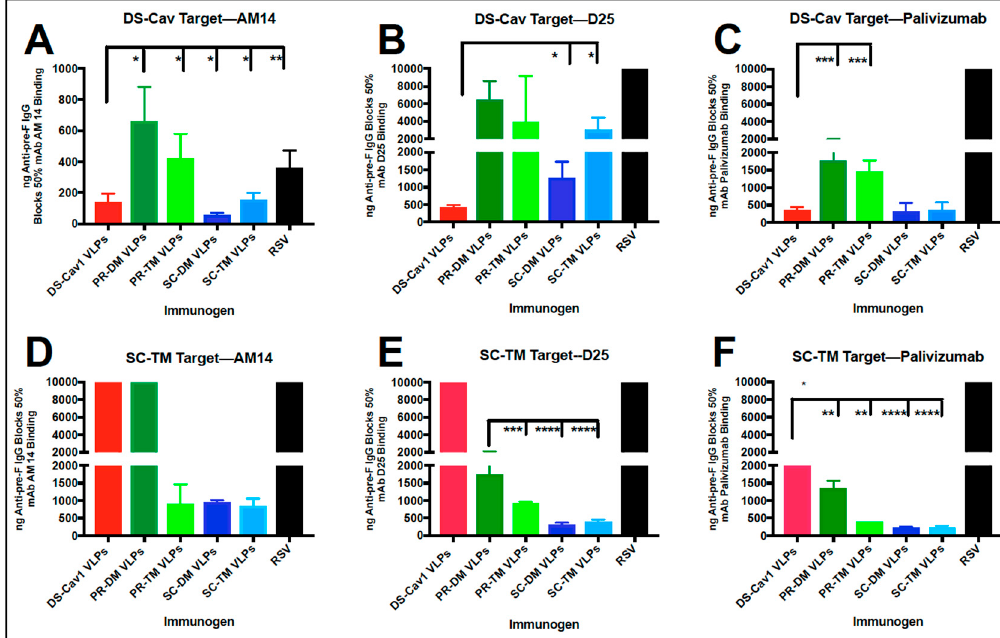
Figure 8. Blocking of the binding of representative mAb by sera from PR, SC, and DS-Cav1 VLP immunizations. Shown are concentrations (ng/mL) of anti-pre-F IgG in pooled sera obtained at four weeks after boost immunizations with all pre-fusion F VLPs and with RSV infection that blocked 50% binding of mAb AM14 (panel A ), D25 (panel B ), and palivizumab (panel C ) to the soluble DS-Cav1 target protein. Panels D , E , and F show concentrations (ng/mL) of anti-pre-F IgG in pooled sera that blocked binding of mAbs AM14, D25, and palivizumab, respectively, to the soluble SC-TM target protein. The results are the mean of at least three separate determinations, with standard deviations indicated. Comparison of values with those of DS-Cav1 VLP sera was assessed by one-way ANOVA. Panel E DS-Cav1 VLP sera did not block binding of D25, thus values were compared to PR-DM VLP sera; **** p < 0.00005 *** p < 0.0005, ** p < 0.005, * p <0.05. Values at or near 10,000 ng/mL indicate failure of the sera to block binding of the tested mAb. Values at or above 2000 ng/mL indicate sera that only very weakly blocked binding. These values were quite variable from experiment to experiment, as indicated by the large standard deviation, and thus were not included in ANOVA analysis.